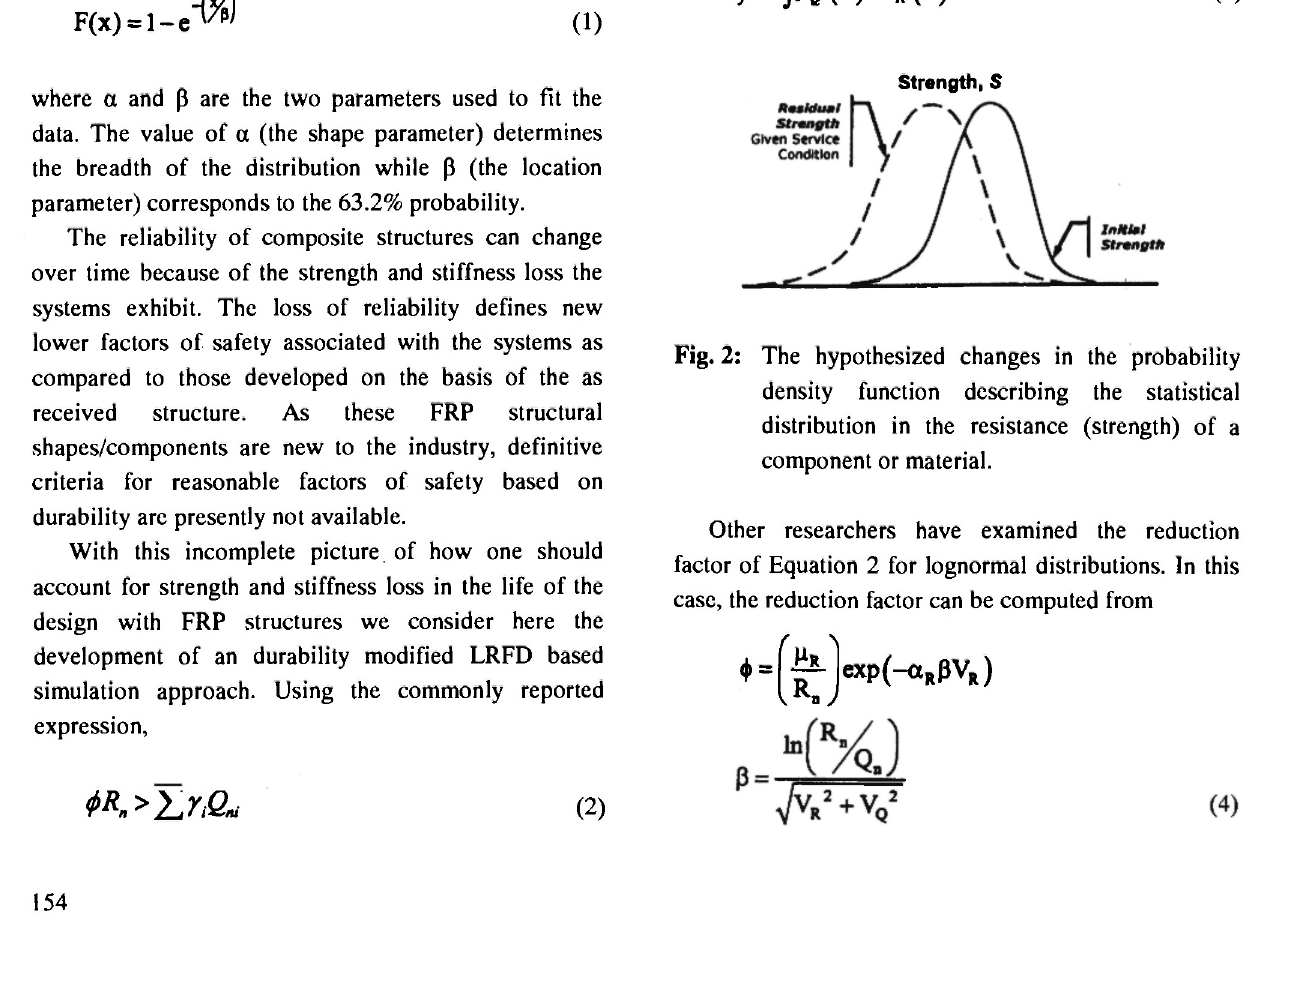
The basis for statistical description of composite